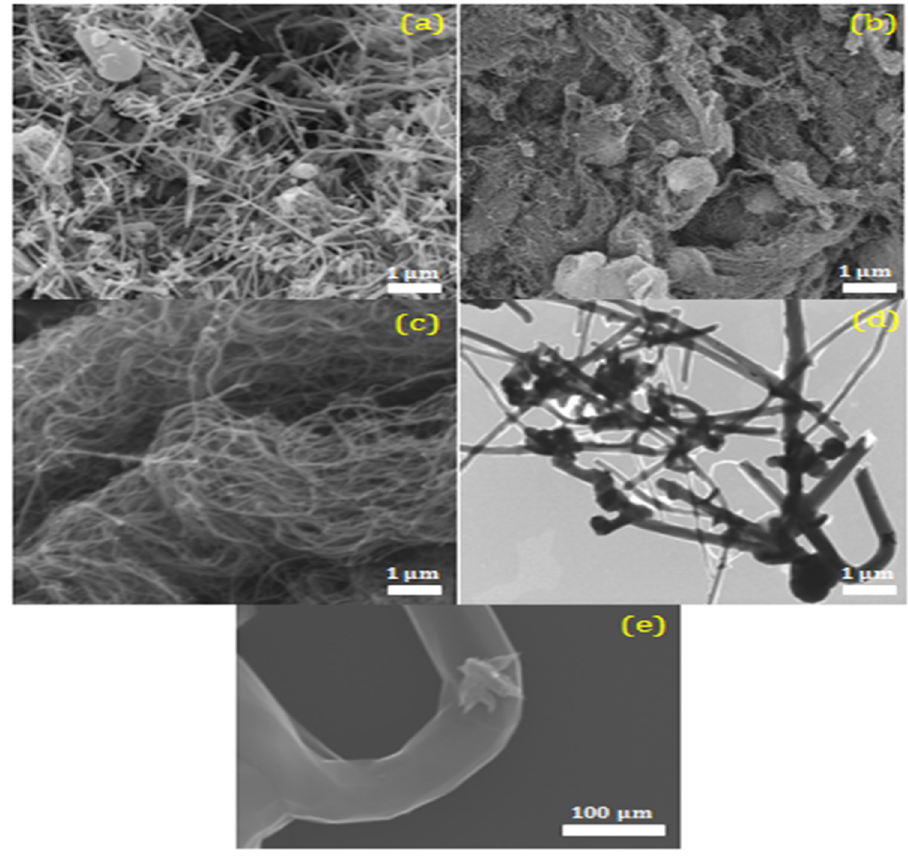
Figure 8: SEM images: ( a ) CNT2, ( b ) CNT1, ( c ) CNT3, ( d ) and ( e ) 4Pd –